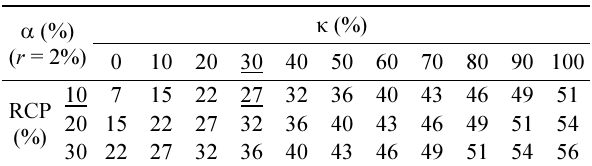
Table 2. Matrix of equity levels ( α ) by reasonable construction profit margin (RCP) and inflated construction profit margin (κ) with fixed interest